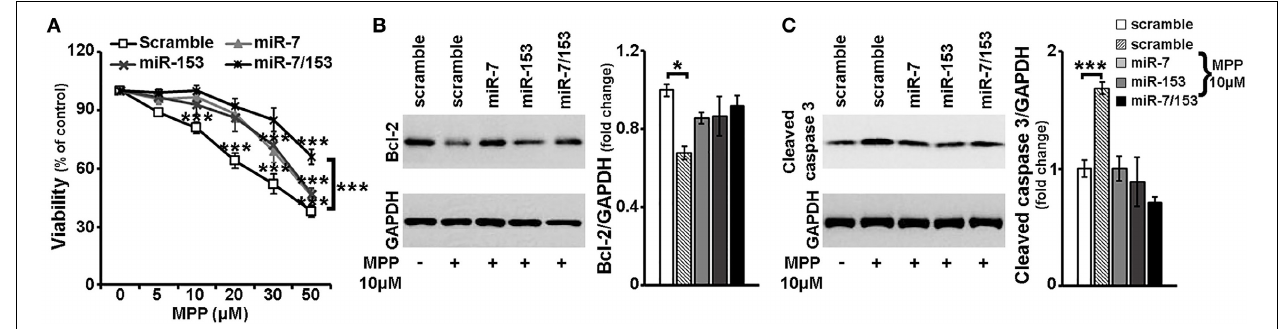
FIGURE 3 | Neuroprotective effects of miR-7 and miR-153 against MPP + -toxicity. Six to seven days old primary cortical neurons were transduced with adenoviral particles expressing scramble miR, miR-7, miR-153, or both miR-7/153. After 24h, transduced neurons were exposed for additional 24h to various concentrations of MPP + . (A) Neuronal viability following MPP + -treatment was monitored by the MTT assay. Note that over-expression of miR-7 and/or miR-153 attenuated MPP + -induced cell death. (B,C) Equal amounts of total protein from lysates of transduced